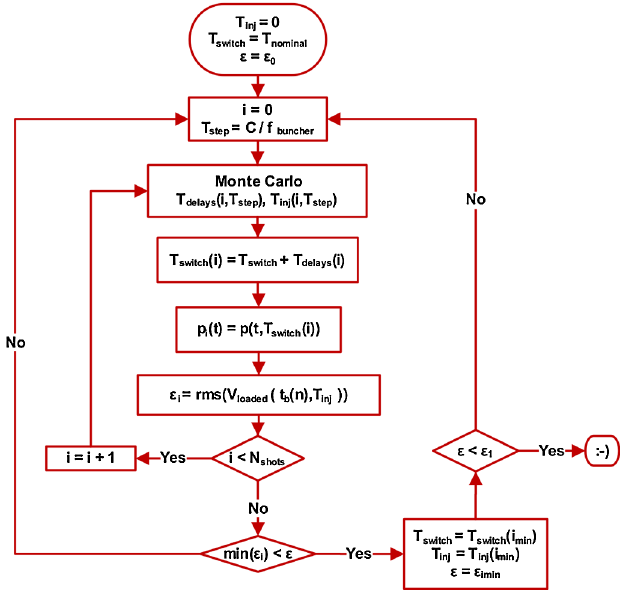
FIG. 12. Flow chart of the optimization